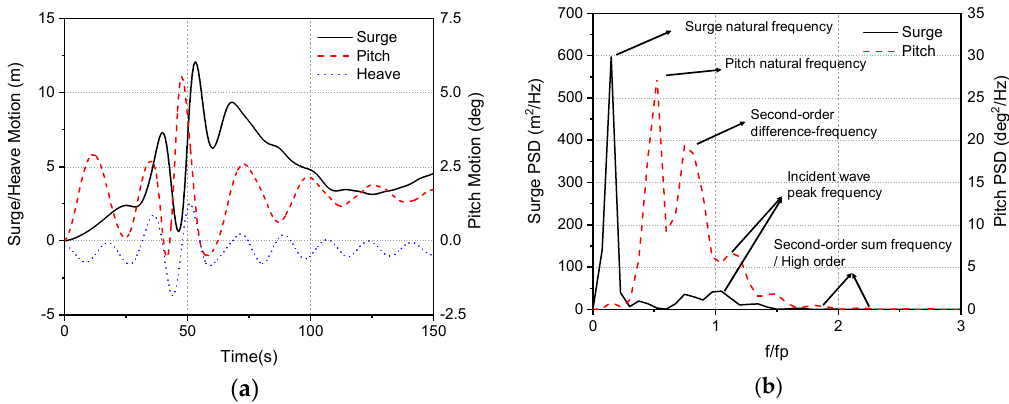
Figure 24. 3DoF motion response for a parked wind turbine under focused wave ( H s = 14.7 m, T p = 15.0 s) and wind ( U = 25 m/s): ( a ) time history of surge, heave and pitch; ( b ) PSDs of surge and pitch.